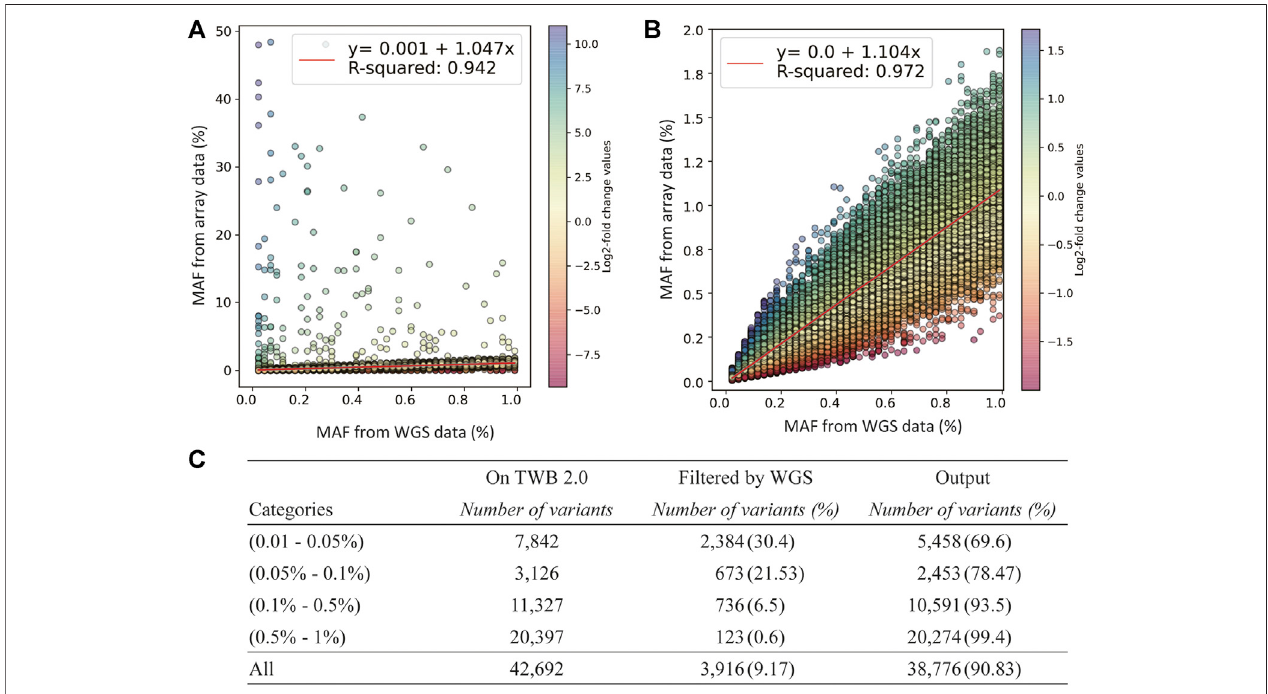
FIGURE 3 | Quality-control assessments on the TWB 2.0 data after performance of rare variant quality-control procedures. (A) Comparison of minor allele frequencies(MAFs)betweensequencingdataandtheTWB2.0beforeexcludinglow-concordanceprobes. (B) Comparison ofMAFsbetweensequencingdataandthe TWB 2.0 after excluding low-concordance probes. (C) The distribution of excluded probes according to the MAF bins.